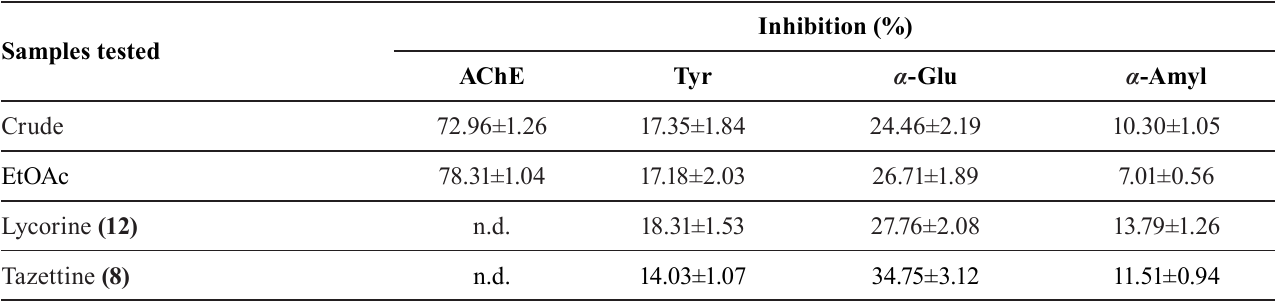
TABLE II – Percentage of inhibition of the samples tested at 100 µg.mL